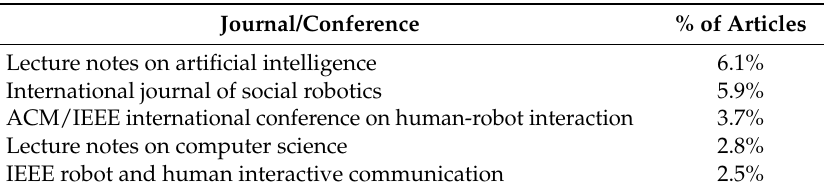
Table 4. Most frequent journals and conferences in social